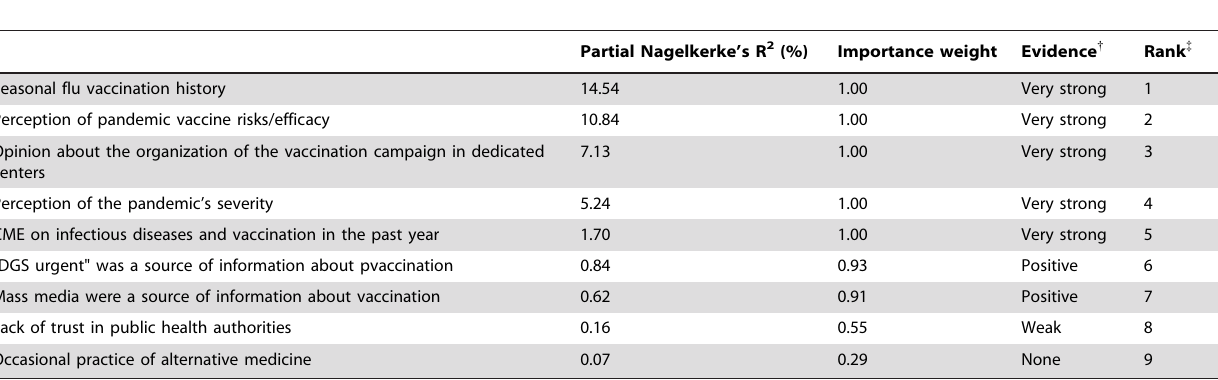
Table 4. Relative contribution and importance of the explanatory factors associated with personal vaccination of GPs against A/ H1N1 flu (French nationwide panel of general practitioners, weighted data, N= 1429: multi-model